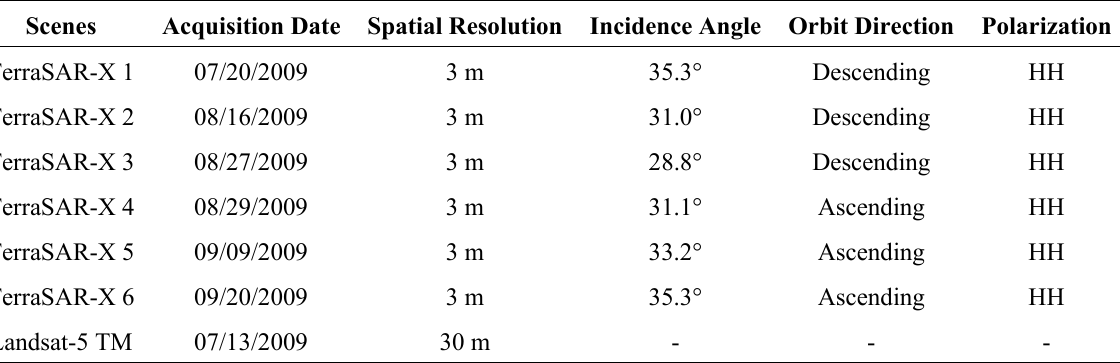
Table 1. Satellite images used in the